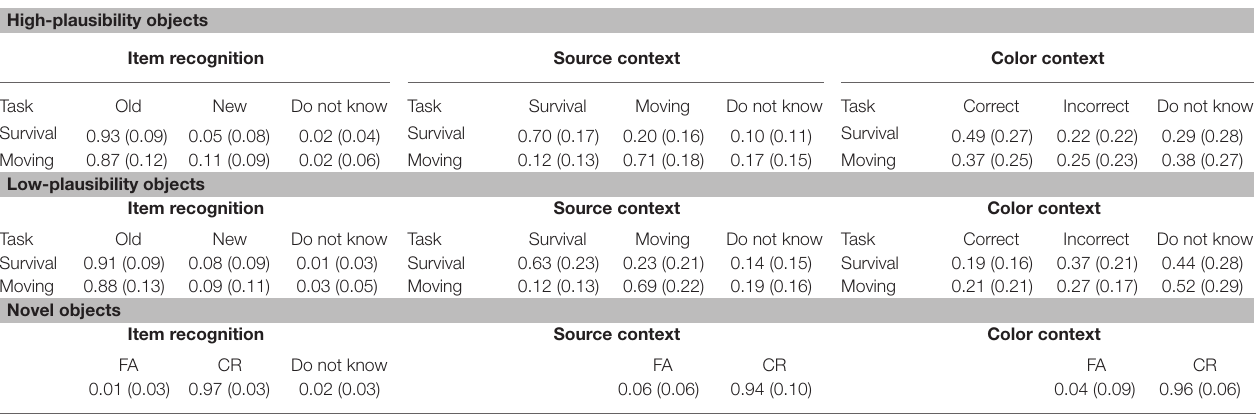
TABLE 1 | Means and standard deviations (in parentheses) of mean raw responses for item, source, and color recognition. High-plausibility